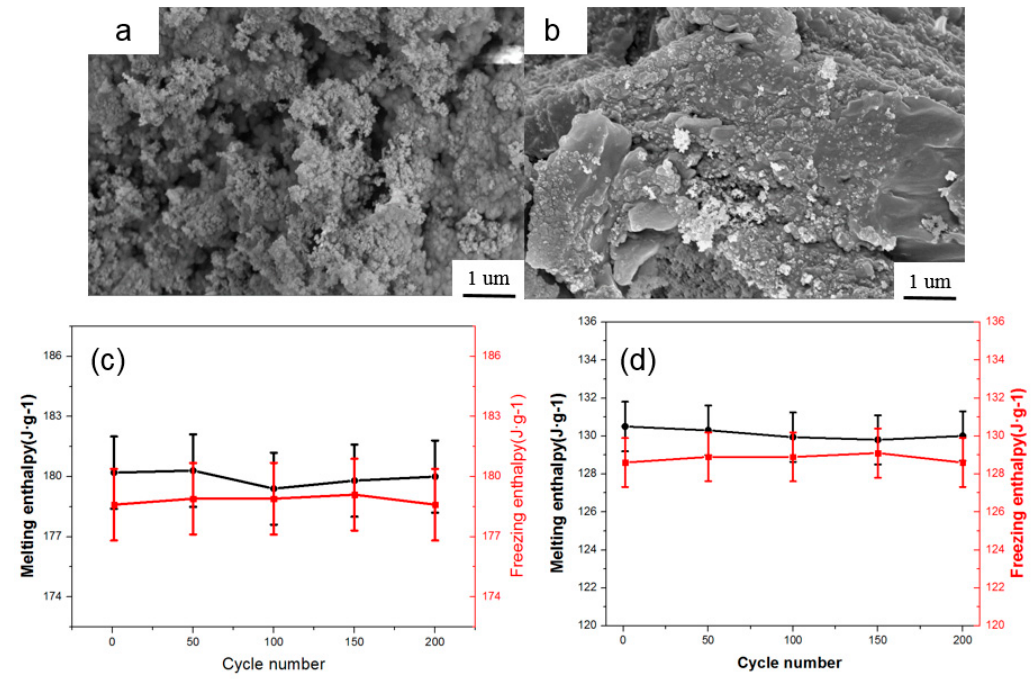
Figure 8. SEM image of RT60 / SiO 2 and RT60 / M-SiO 2 aerogels after 200 heating / cooling cycles ( a , b ). Absolute values of the melting and freezing enthalpy of RT60 / SiO 2 and RT60 / M-SiO 2 aerogels after di ff erent heating / cooling cycles ( c , d ) are shown.